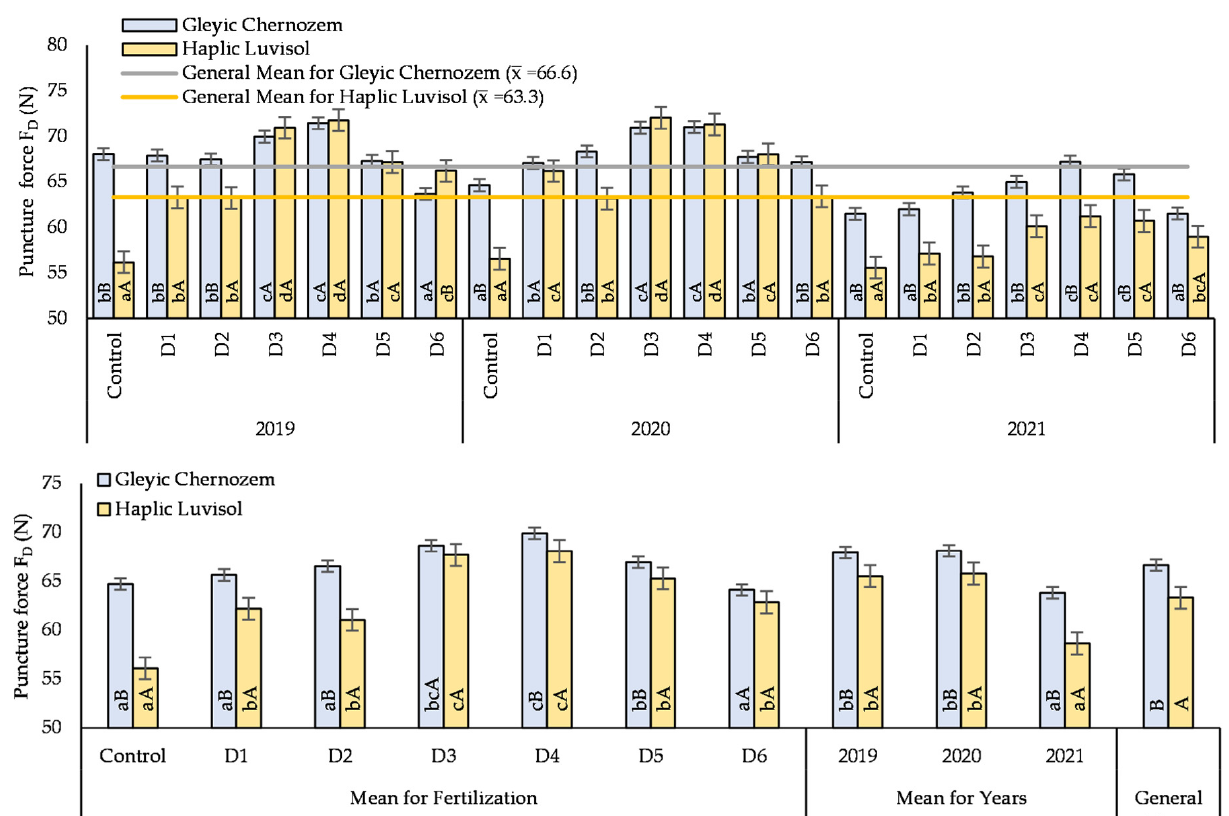
Figure 4. Average values of the puncture force of potato tuber peels and flesh F D (N) depending on the type of soil, fertiliser applied and year of research. Statistical data are expressed as mean ± SD values. Different letters show significant differences ( p < 0.05) according to Tukey’s range test. Capital letters mean differences between particular types of soil, small letters mean differences between particular doses of fertiliser.